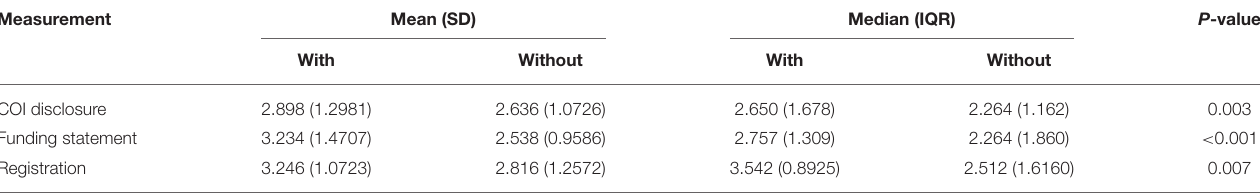
TABLE 1 | Mean and median of Journal Impact Factor (JIF) for papers with different levels of transparency. Measurement Mean (SD) With Without